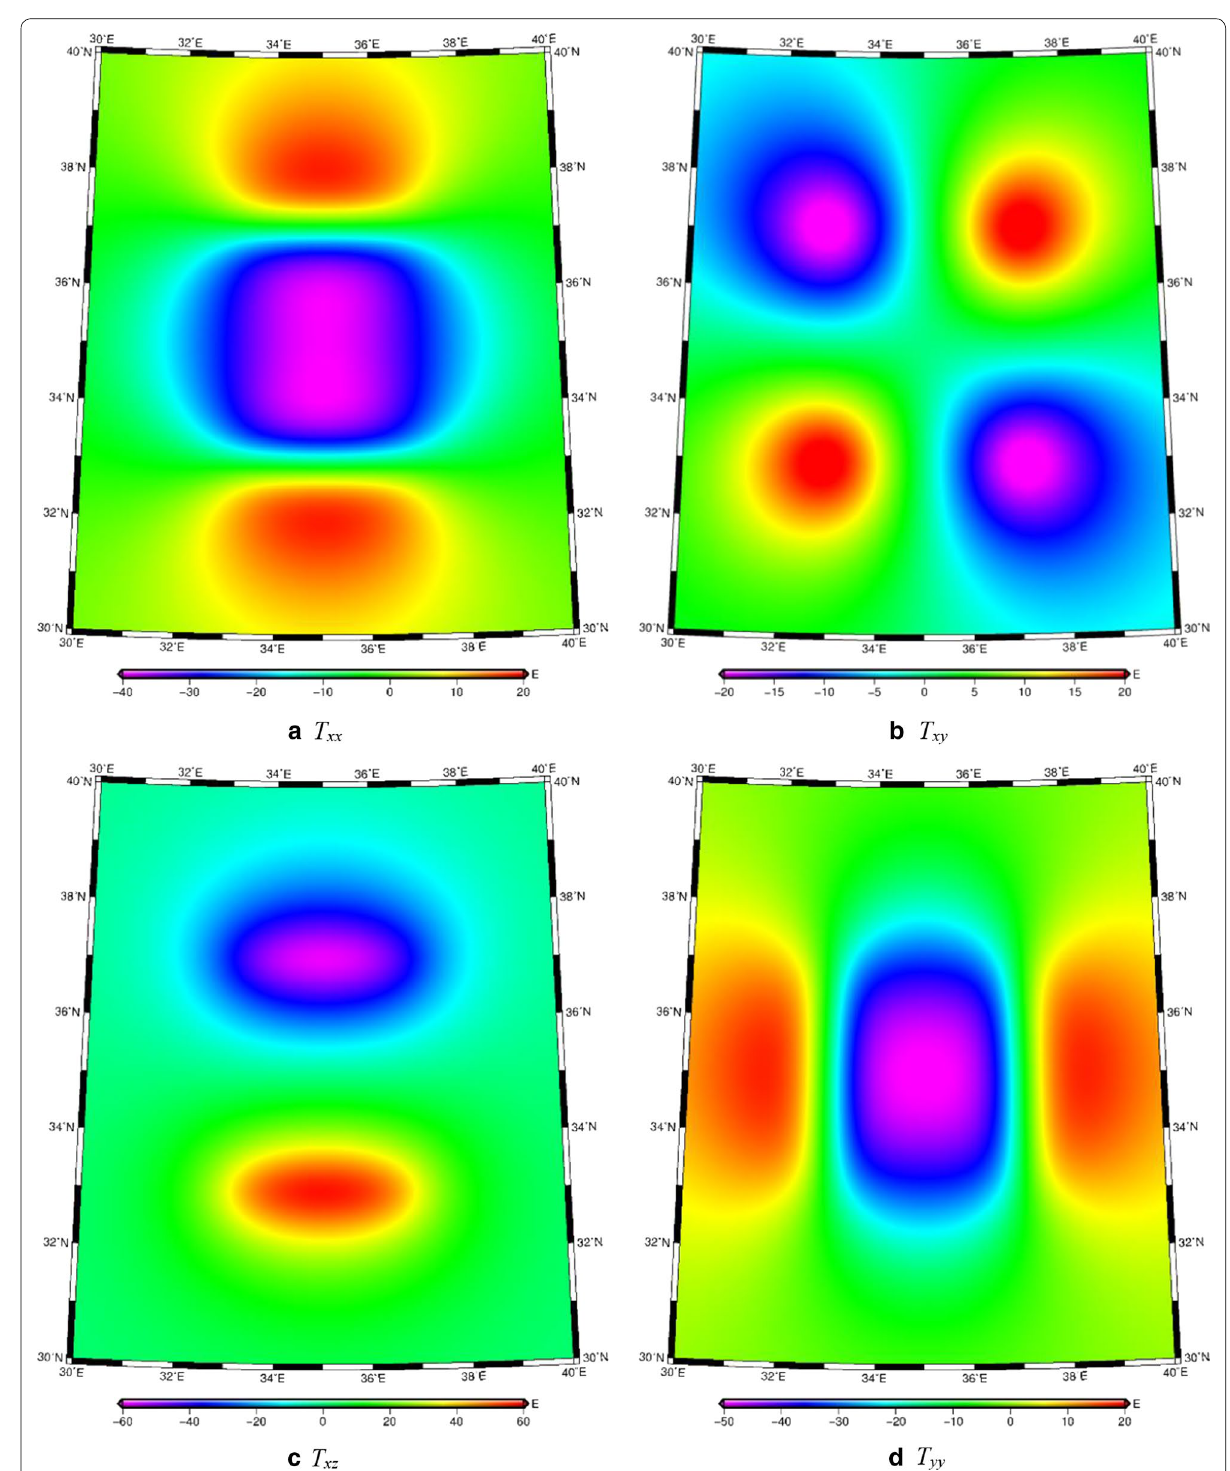
Fig. 3 Artificial theoretical datasets of the GGT for single model, a , b , c and d are T xx , T xy , T xz and T yy components,